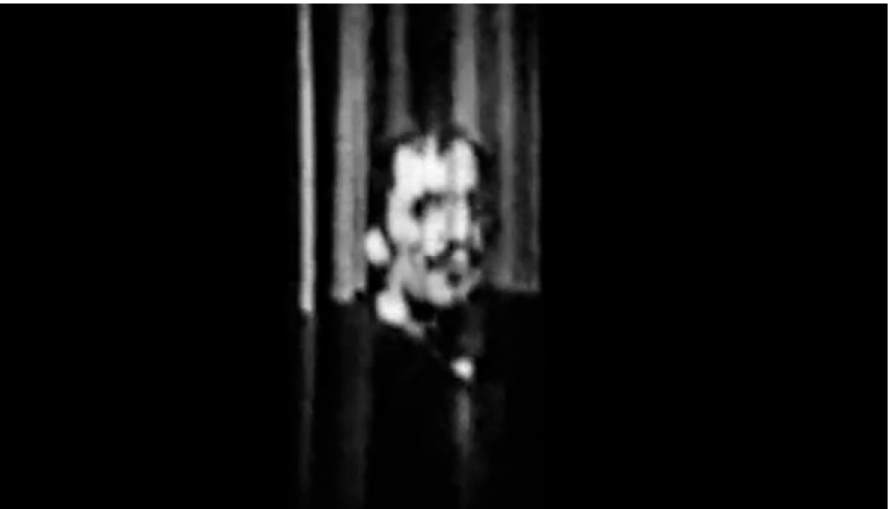
Figure 3. Still from The Man with a Flower in His Mouth (1930) using John Logie Baird’s 30 line television system.